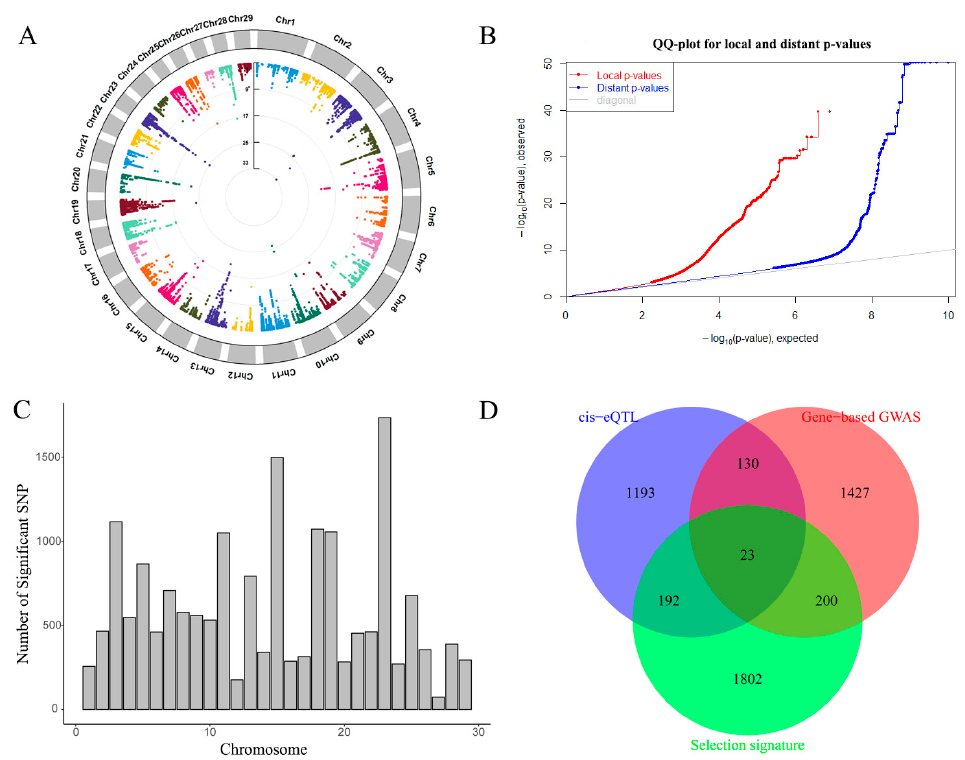
Figure 2. ( A ) The CMplot of eQTLs, chromosomes are shown in different colors. ( B ) The QQ plot of eQTLs. ( C )The distribution of significant cis-eQTL SNPs in autosomes. ( D ) The Venn plot among gene sets from eQTL, gene-based GWAS and selection signature.